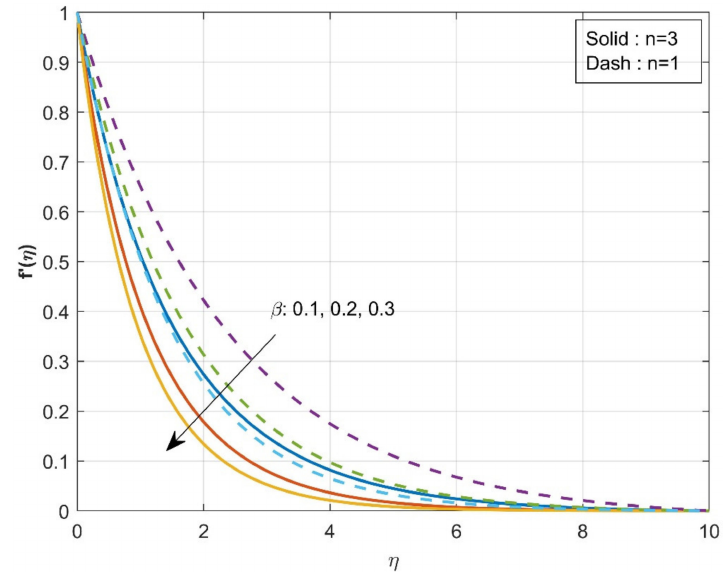
Figure 2. Influence of β over axial velocity f (cid:48) ( η )